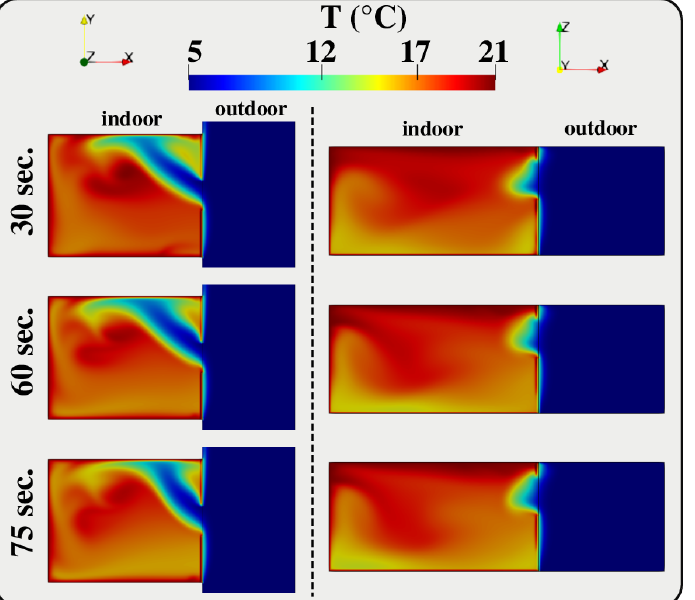
Figure 5. Indoor-outdoor temperature field. Case: Natural ventilation due to a low wind speed out- doors U y = 4 km/h and a lower outdoor temperature, walls-particles-interaction: stick . Left hand side Column: XY-plane perspective view; Right-hand side Column: XZ-plane perspective